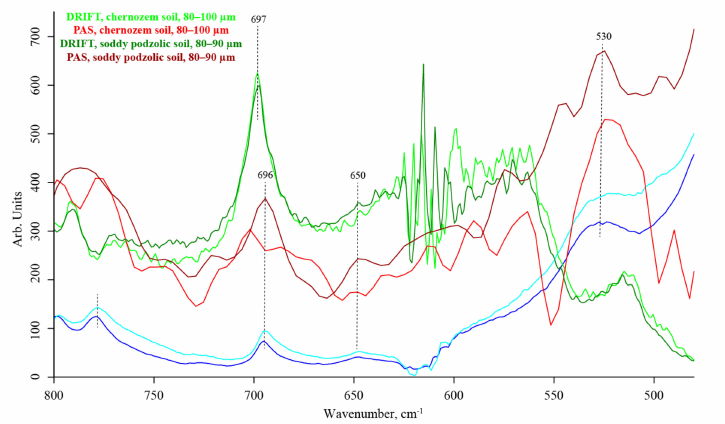
Figure 10. Normalized FTIR spectra in 800–450 cm − 1 . DRIFT, ATR, and PAS (IMF 1.6 kHz) spectra of shelterbelt chernozem soil (dry fractionation, 80–100 µ m), light green, light blue, and light red, respectively; and DRIFT, ATR, and PAS (IMF 1.6 kHz) spectra of sod-podzolic soil (dry fractionation, 80–90 µ m), dark green, dark blue, and dark red, respectively.